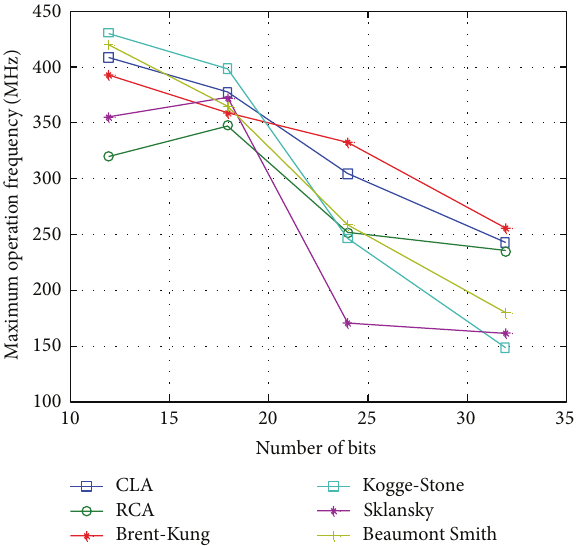
Figure 5: Comparison result of maximum operating frequency ( 𝐹 Max ) for phase accumulator design with CLA, Brent-Kung, Kogge- Stone, Sklansky, Beaumont-Smith, and RCA adders.